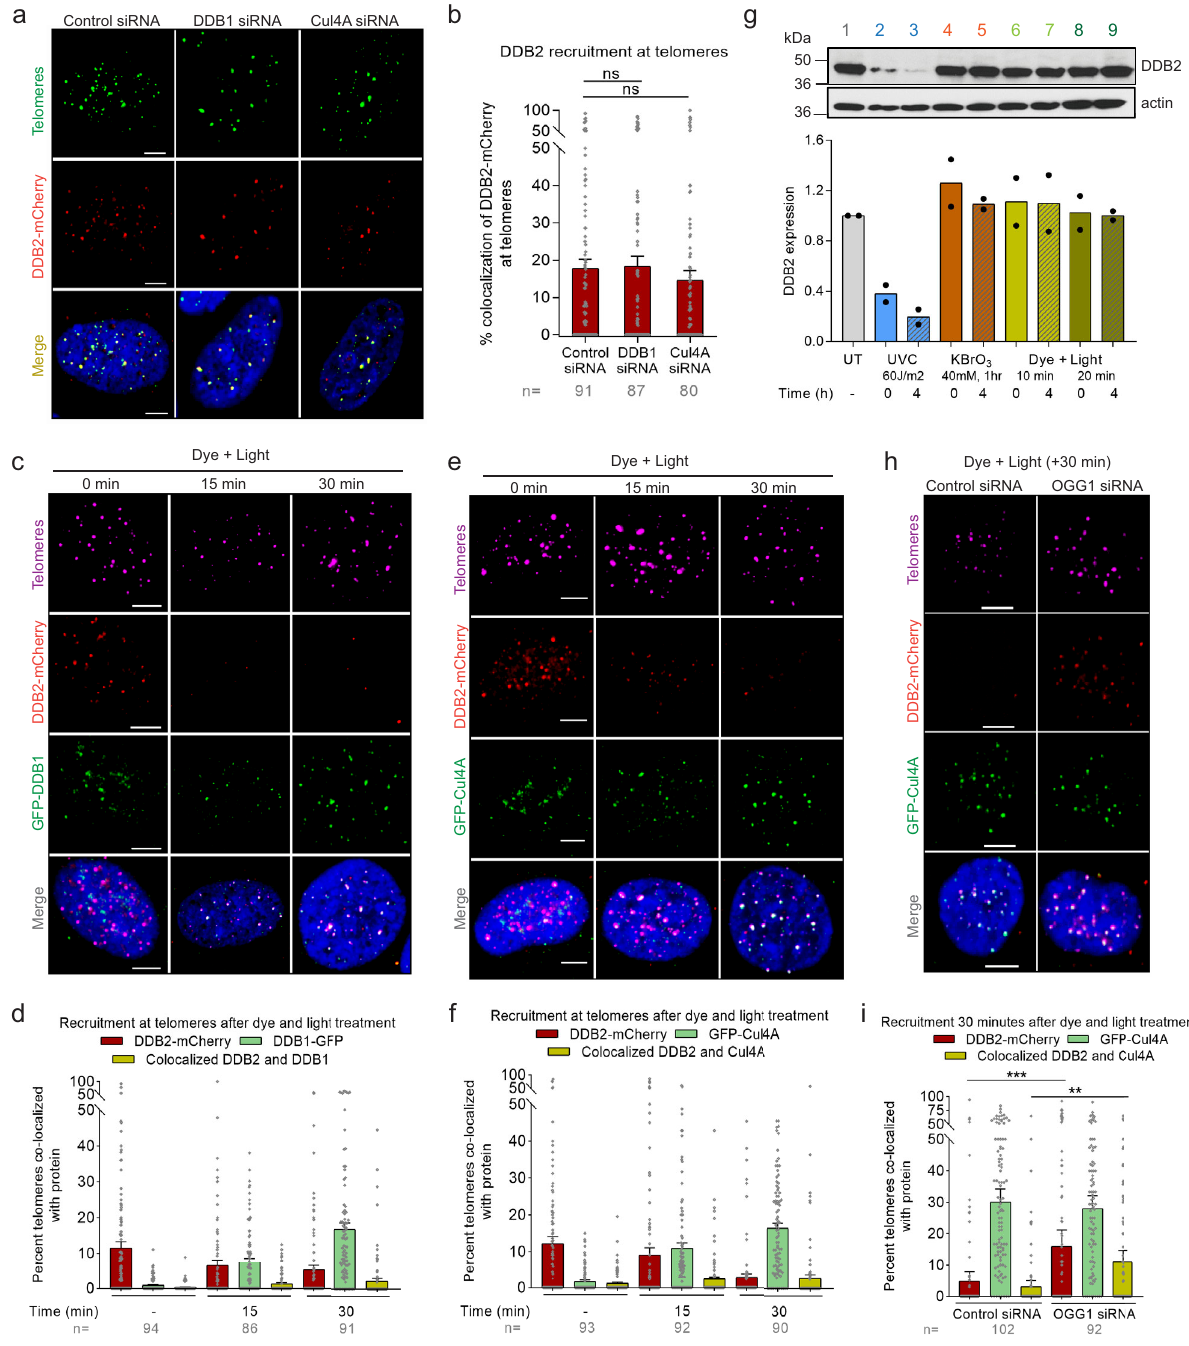
Fig. 4 DDB2 binds sparse telomeric 8-oxoG independently of the DDB1-Cul4A-RBX1 E3 ligase. a Representative images showing recruitment of DDB2- mCherry to telomeric 8-oxoG in cells transfected with control, DDB1 or Cul4A siRNA. b Quanti fi cation of a. c , e DDB2-mCherry and GFP-DDB1 ( c ) or DDB2-mCherry and GFP-Cul4A ( e ) accumulation at 8-oxoG sites after dye (100 nM, 15 min) plus light (660 nm, 10 min) treatment. d , f Quanti fi cation of c and e respectively. g Western blot for DDB2 in U2OS-FAP-TRF1 cells treated with UVC, potassium bromate (KBrO 3 ) or dye plus light at indicated doses. Independent experiments are represented by black circles. h Colocalization of DDB2-mCherry and GFP-Cul4A at damaged telomeres in U2OS-FAP-TRF1 cells transfected with control or OGG1 siRNA. i Quanti fi cation of h. Data ( a – h ) represents mean ± SEM from two independent experiments. ‘ n ’ represents the number of cells scored for each condition. One-way ANOVA (Sidak multiple comparison test) ( b , i ) was performed for statistical analysis: * p < 0.05, ** p < 0.01, *** p < 0.001, ns Not signi fi cant. Scale: 5 µ m. Source data are provided as a Source Data fi le. (See also Supplementary Fig.